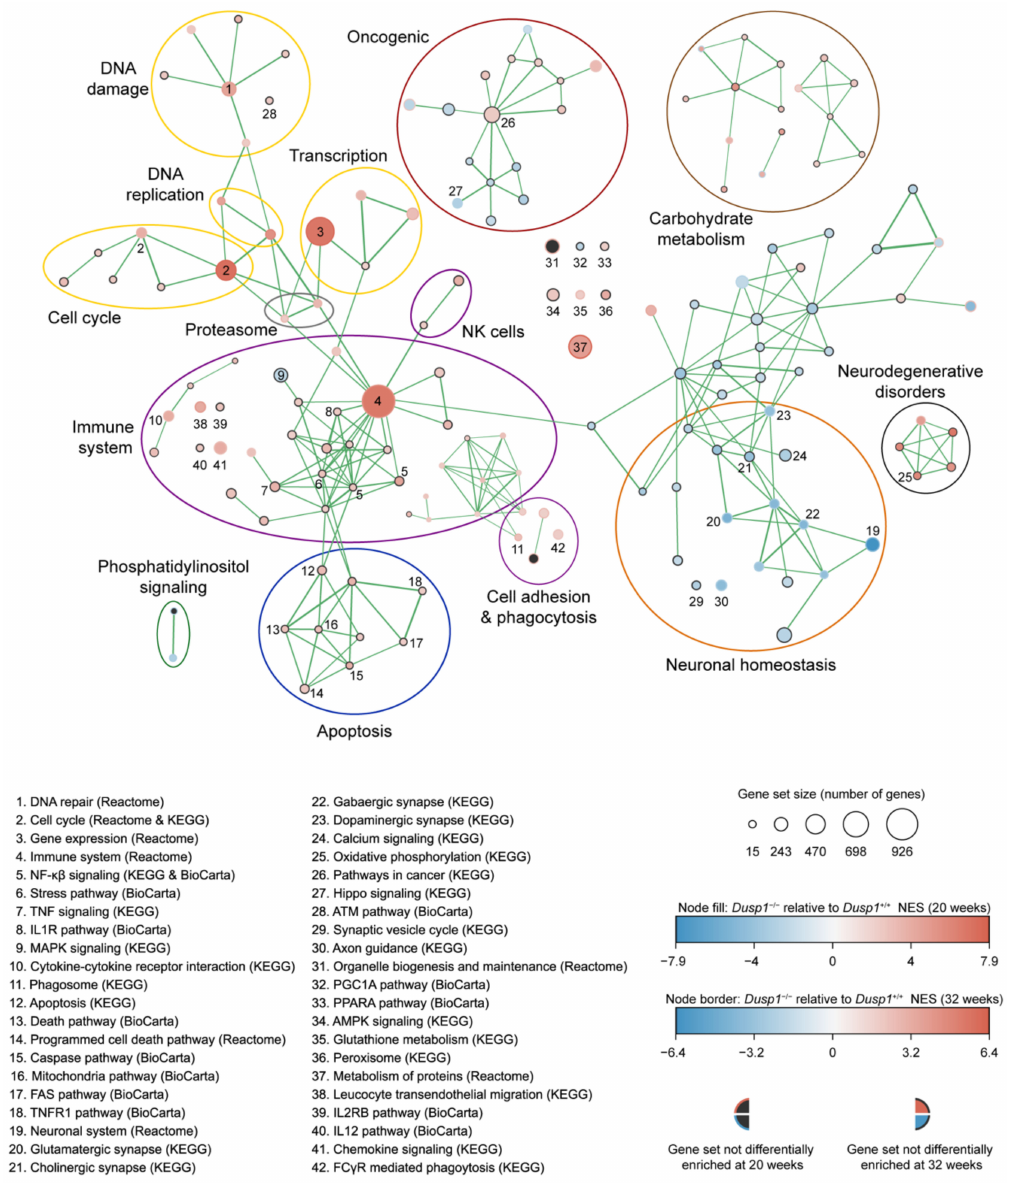
Figure 1. Gene-set enrichment analysis of RNAseq data sets from 20- and 32-week-old Dusp1 +/+ and Dusp1 − / − cochlea. Enrichment analysis visualization for identification of altered gene sets (nodes). Gene sets derive from Reactome, KEGG and BioCarta databases. Node size denotes gene set number. Differentially enriched gene sets in 20-week-old Dusp1 − / − mice are designated by node fill while node border designates 32-week-old data. Normalized enrichment value (NES) for each time point is illustrated in a color scale from blue (negative enrichment) to red (positive enrichment). No representation of the gene set at either time point is shown by a grey node fill or grey border, respectively. Connection between nodes is represented by lines. Line width symbolizes number of genes shared by both nodes. Most interesting nodes are numbered and listed (1–42). Related nodes are grouped in modules and labeled accordingly. Related modules share the same